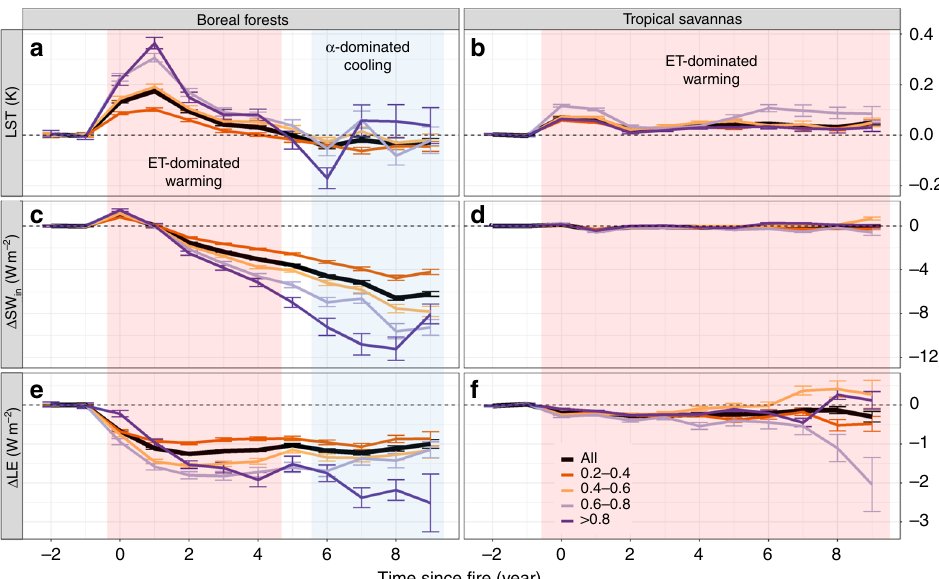
Fig. 3 Land surface radiometric temperature (LST) after fi re in boreal forests and tropical savannas. Time series plots of changes in land surface radiometric temperature ( △ LST, a , b ), shortwave radiation ( △ SW in , c , d ), and latent heat fl uxes ( △ LE, e , f ) for tropical savannas and boreal forests, strati fi ed by different percent of area burned within each CMG grid (i.e., All, 0.2 – 0.4, 0.4 – 0.6, 0.6 – 0.8, > 0.8). Error bars are one standard